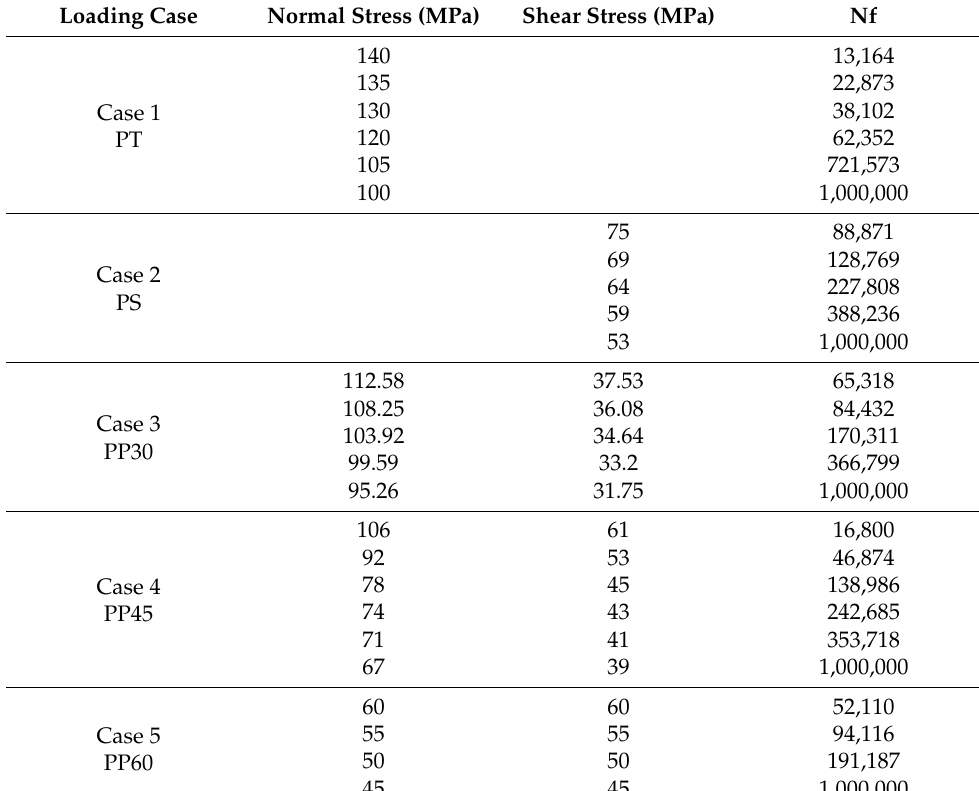
Table 3. Az31B-F experimental fatigue data for proportional loading paths, Cases 1 to